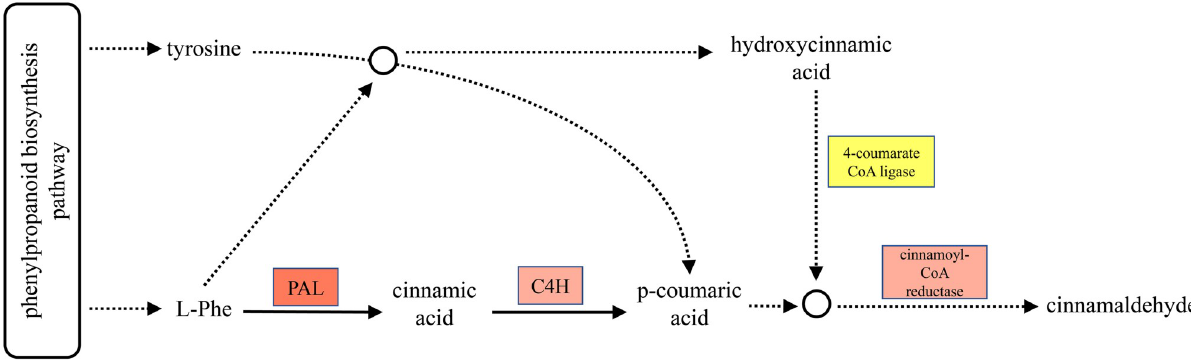
Fig 7. Phenylpropanoid biosynthesis